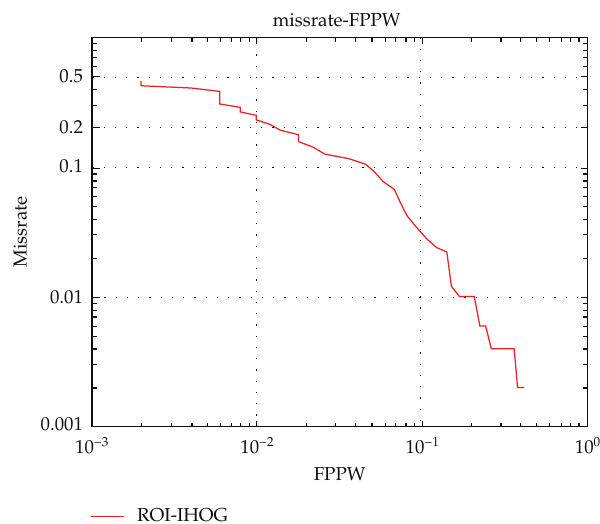
Figure 9: Performance on ROI-IHOG-based pedestrian